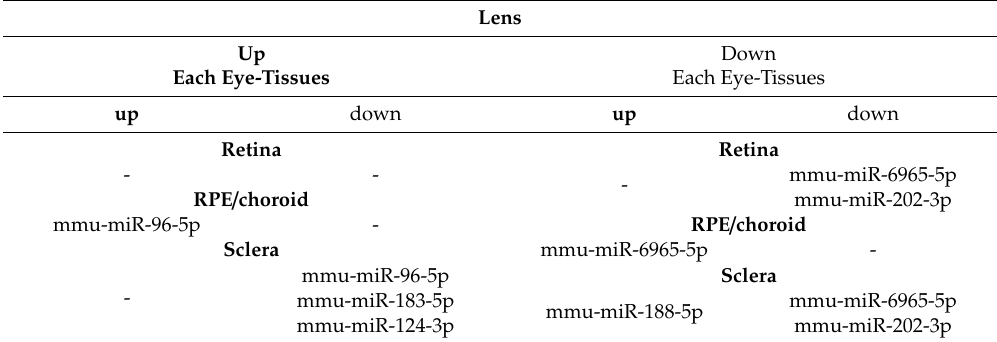
Table 4. Overlapping expression changes in miRNAs in lens and other ocular tissues.